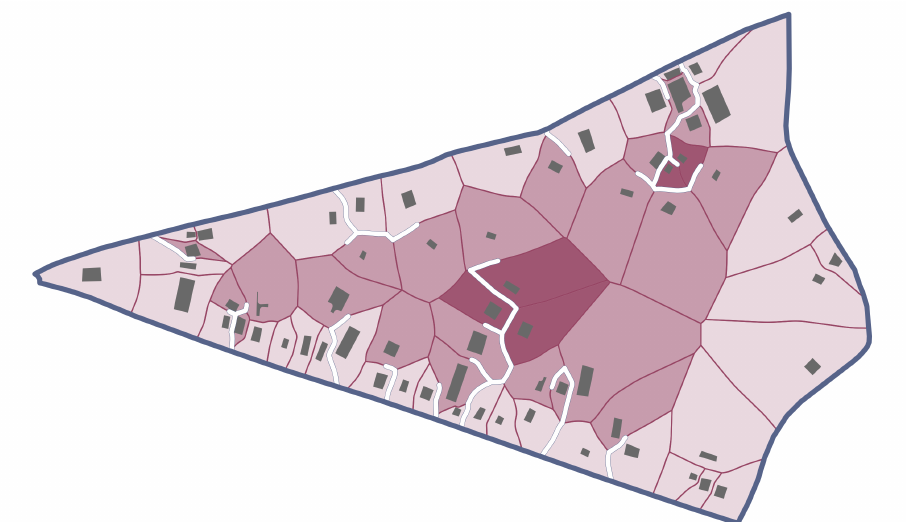
Figure 7. Reblocked block in Freetown, Sierra Leone. Using the graph structure generated from the cadastral parcels, we can determine how many parcels are not adjacent to the block boundary, and calculate the least-cost network of additional street segments (white) that will connect every building (gray) to the existing street network (blue). We pose this as a Steiner tree approximation problem and estimate the smallest length set of parcel edges that, if turned into streets, would connect every building to the boundary and reduce the block’s k